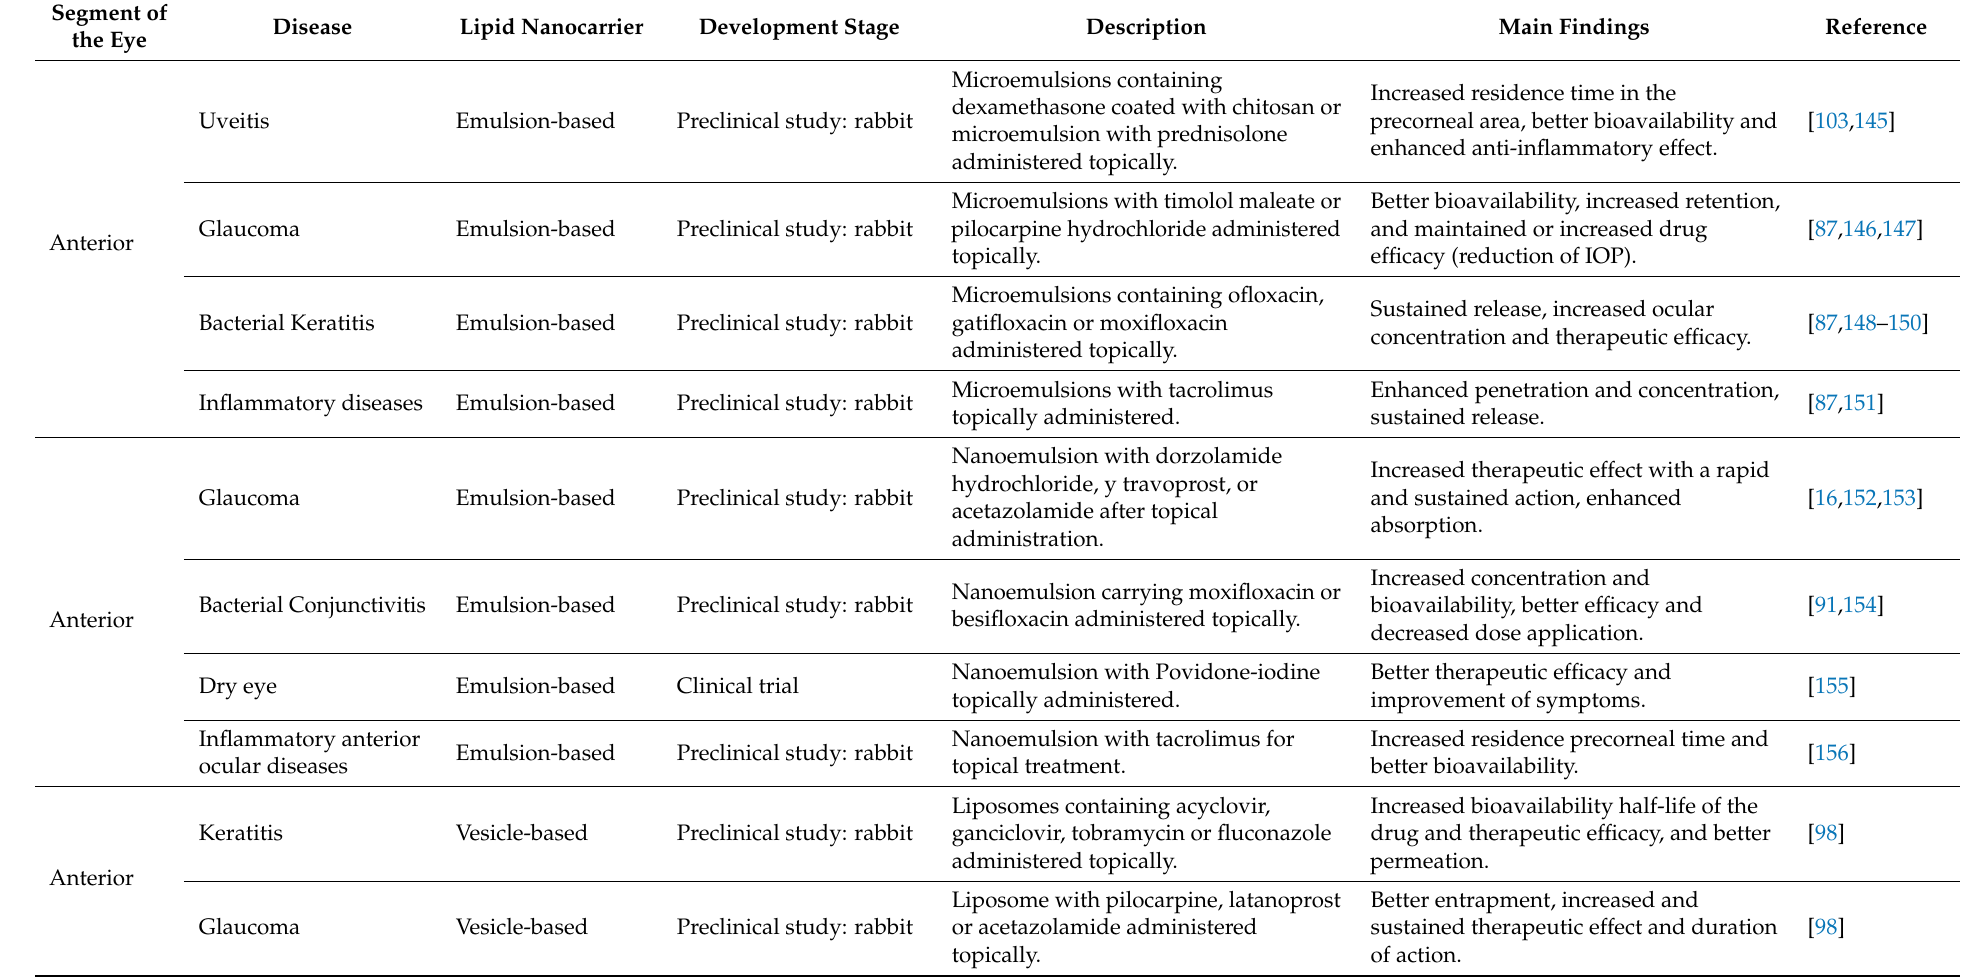
Table 2. Comparative table of lipid-based nanocarriers for the anterior and posterior